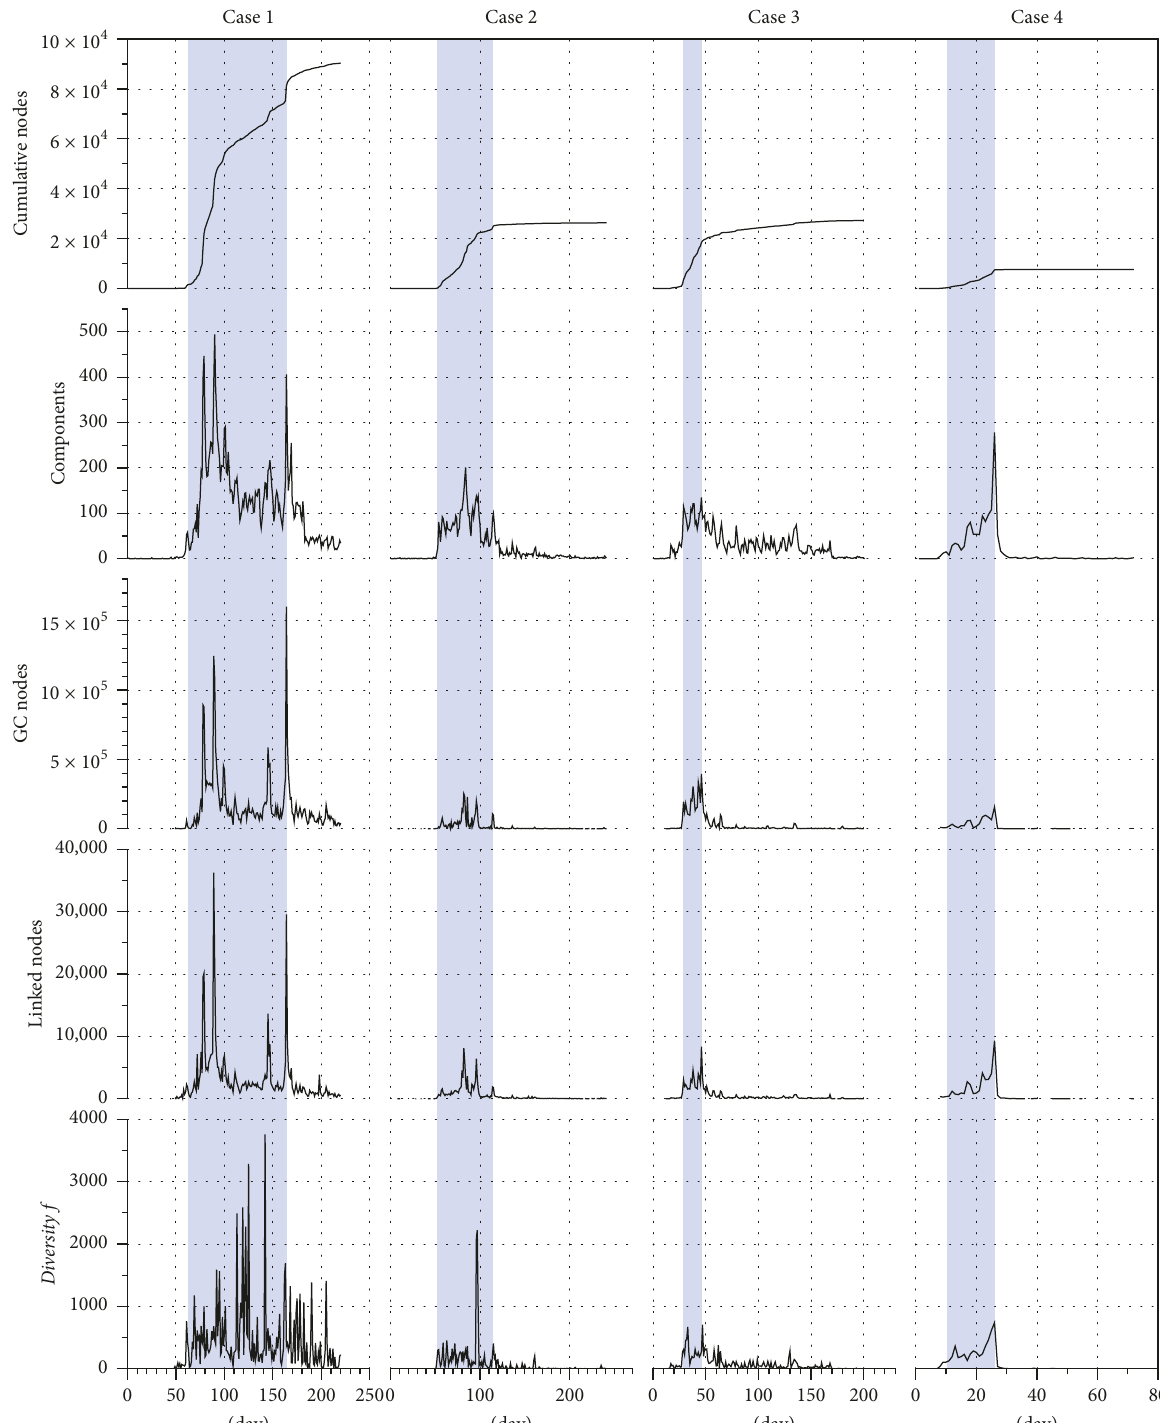
Figure 4: Participating users (top), number of components (mid top), nodes in the major component (mid), number of linked nodes (mid bottom), and Diversity 𝑓 (bottom) for each case studied in each 𝐺(𝑑) analyzed. The colored region corresponds to the most active moments (number of tweets